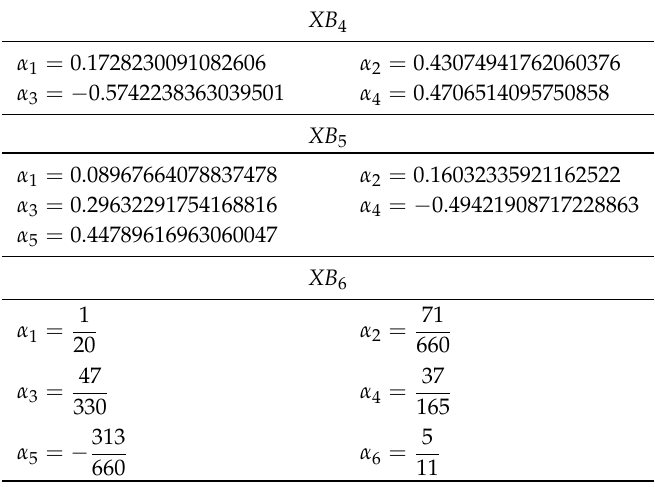
Table 3. Fourth-order composition methods XB s with s stages minimizing E 3